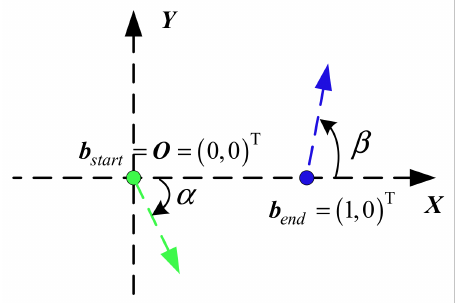
Figure 15. The boundary constraints of G1 interpolation in normalized